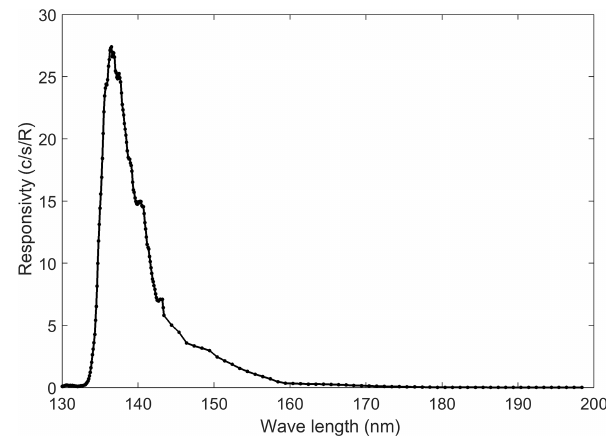
Figure 3. The IPM responsivity of the 135.6nm nightside channel in counts/s/R.